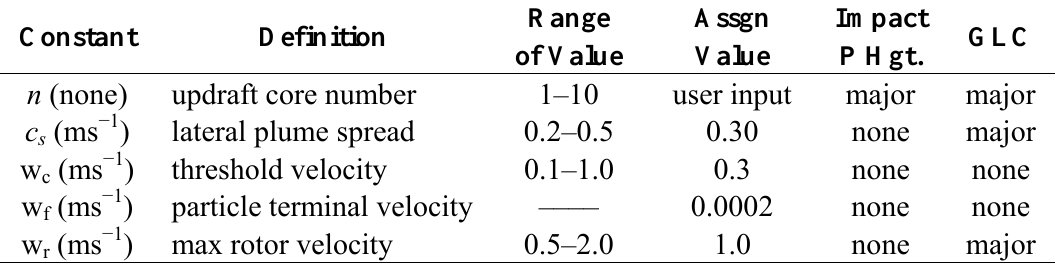
Table 1. Assigned coefficients and constants and the expected impact on